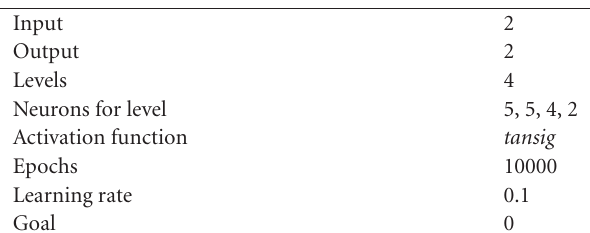
Table 3: Data of the FFBPNN.